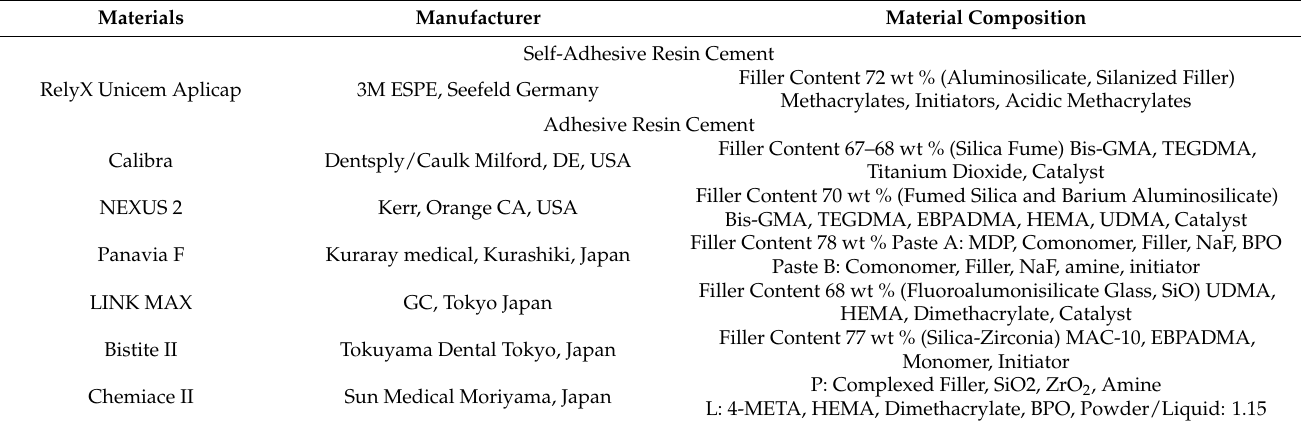
Table 1. Luting-agents investigated. Information provided by the